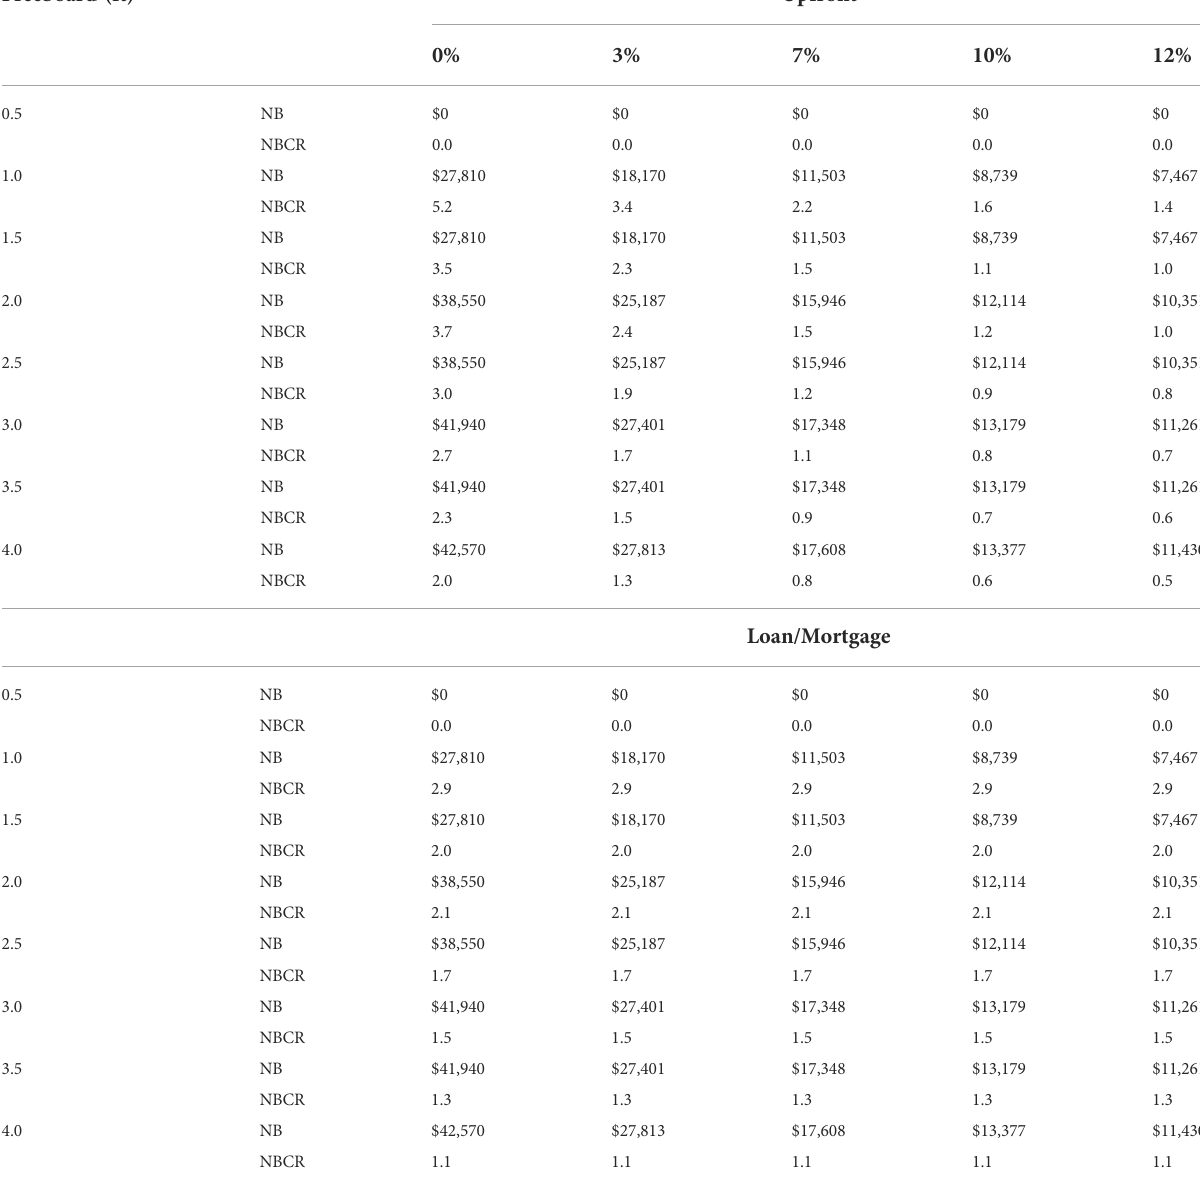
TABLE 8 BCA Results of Flood Premiums by Discount Rate, Freeboard Scenario, and Upfront vs. Mortgage Option. Freeboard